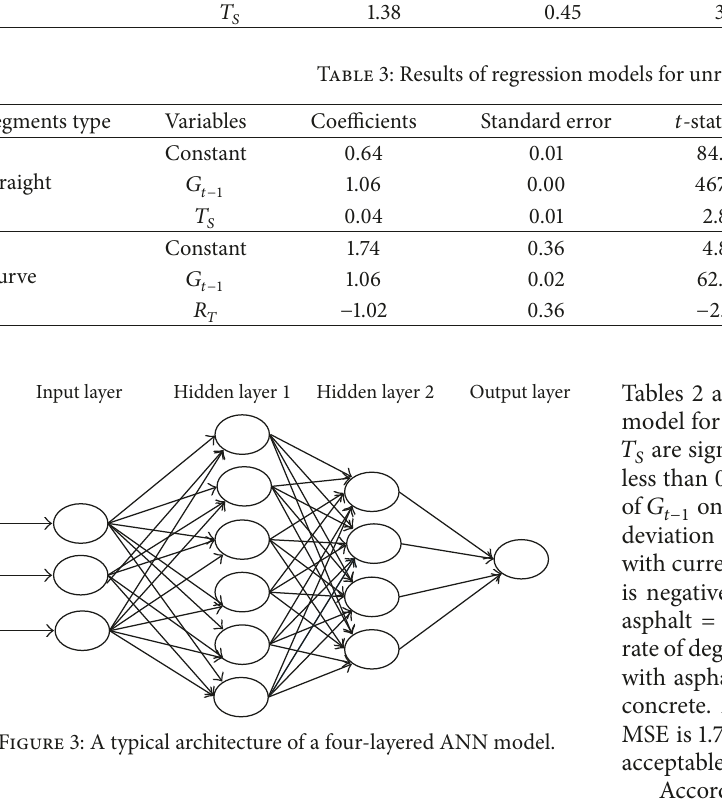
and a linear transfer function (PURELIN) was used for the output